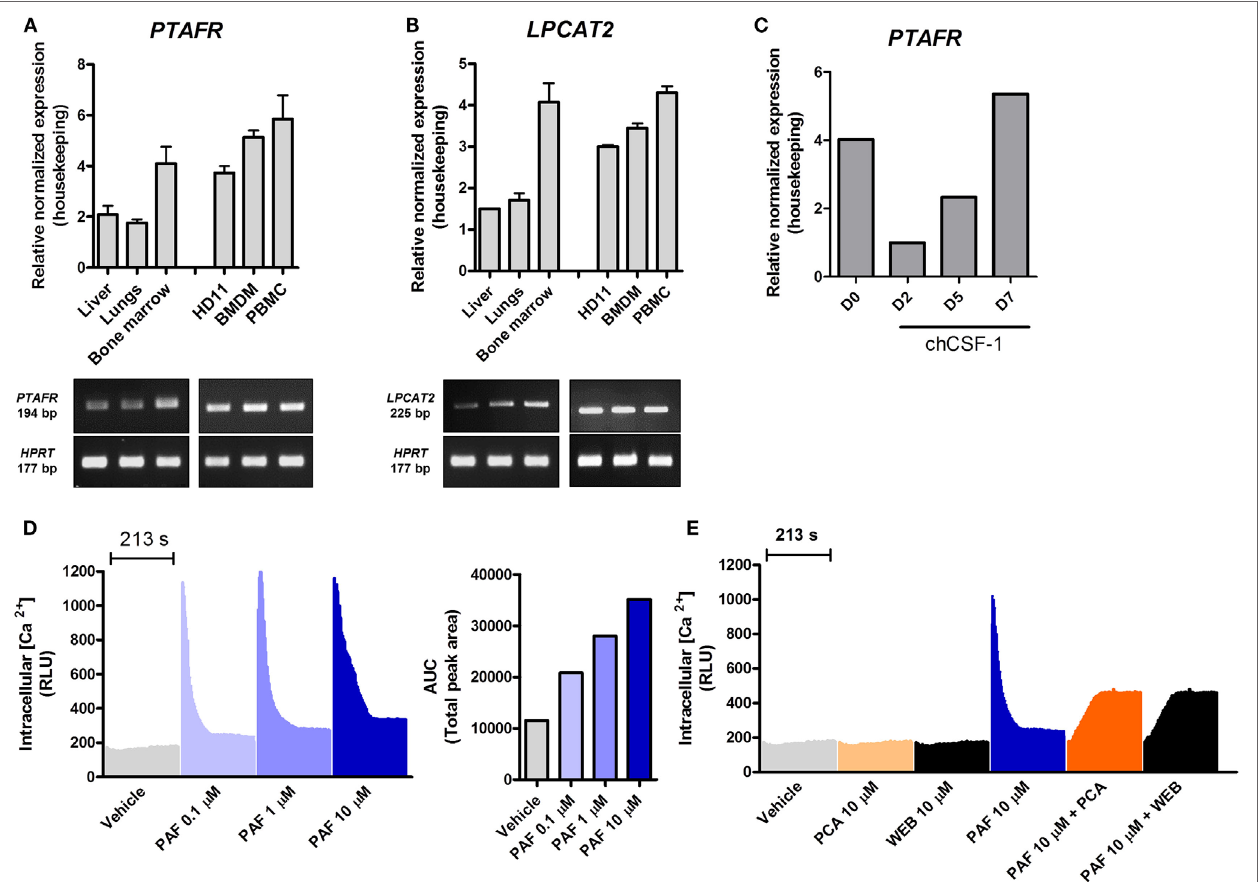
FigUre 1 | Components of the platelet-activating factor (PAF) system are expressed in chickens, and exogenous PAF induces intracellular calcium increase in chicken macrophages. (a) The gene expressions of PAF receptor (PAFR)/ PTAFR and (b) LPCAT2/ LPCAT2 were evaluated by quantitative real-time PCR (qRT-PCR) in unstimulated chicken tissues and macrophages [HD11 macrophage-like cells, bone marrow-derived macrophages (BMDM) and peripheral blood mononuclear cells (PBMC)]. Amplicon size (in base pairs, bp) was confirmed in 2% agarose gels. (c) PAFR/ PTAFR gene expression was evaluated by qRT-PCR in purified bone marrow cells following chCSF-1 medium complementation for BMDM differentiation from days 0 to 7. Data are expressed as relative normalized expression (as compared to two housekeeping genes). Values are mean ± SEM. In (D,e) the HD11 cell line was stimulated with PAF and/or PAFR antagonists (PCA 4248 and WEB 2086), and the increase in intracellular calcium signal was recorded over time (216 s, 3 s intervals) using a fluorescent probe. RLU, relative luminescence units; AUC, area under the